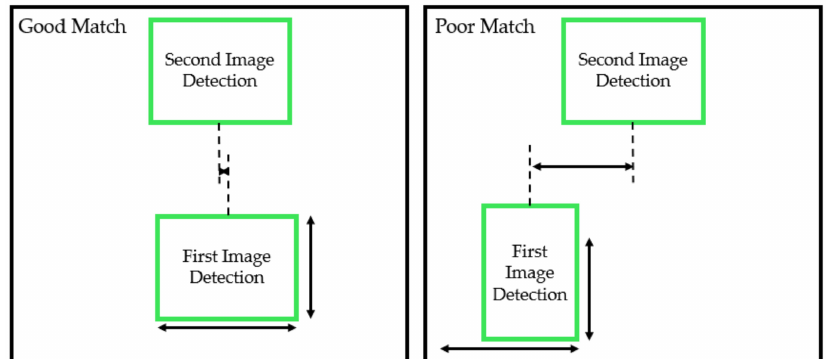
Figure 7. Visual representation of how detections in consecutive images are compared. If the two points are similar enough, the second detection is given the same class as the first. As the camera is moved in a straight line, leaves in the camera’s view should not greatly move from side to side from the camera’s perspective, only up and down, which can be used to predict depth.